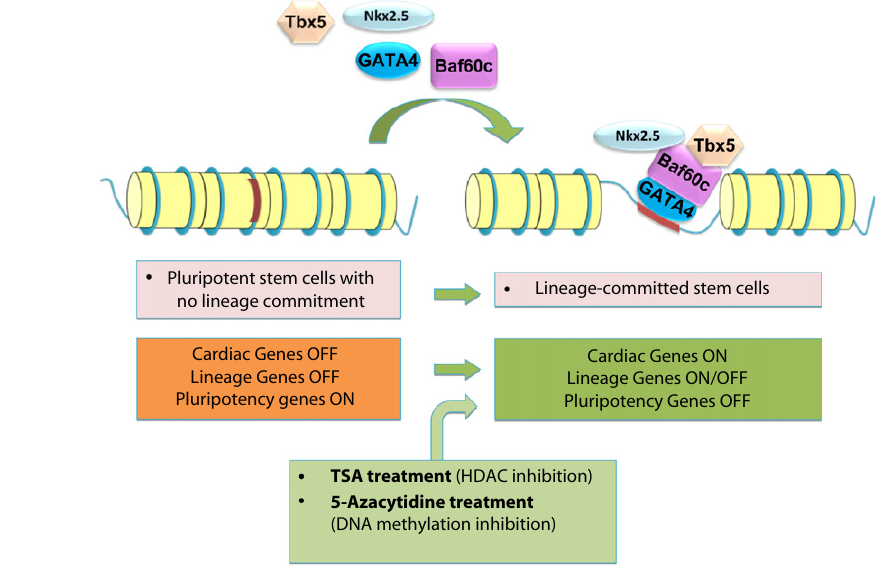
Figure 5. The cardiogenic factors turn cardiac genes on during differentiation of pluripotent stem cells into cardiomyocytes lineages. The transcription factors, Gata4, Tbx5 and Nkx2.5, cannot access the DNA unless the chromatin modifying protein Baf60c is present. When all four are introduced, Baf60c helps open up the condensed chromatin, and allows Gata4, Tbx5 and Nkx2.5 to work together and activate cardiac gene expression. In addition, pharmacological treatment with histone deacetylase inhibitors (e.g. TSA) or with the DNA demethylating agent 5-azacytidine induces cardiogenesis, presumably by increasing the transcription of the same cardiogenic factors. The pluripotency genes are turned on in stem cells and they are turned off during differentiation to cardiomyocytes. The specific lineage committed genes are turned off at stem cells and some of them have to be turned on, whilst some others need to be turned off depending on the cell fate decision.